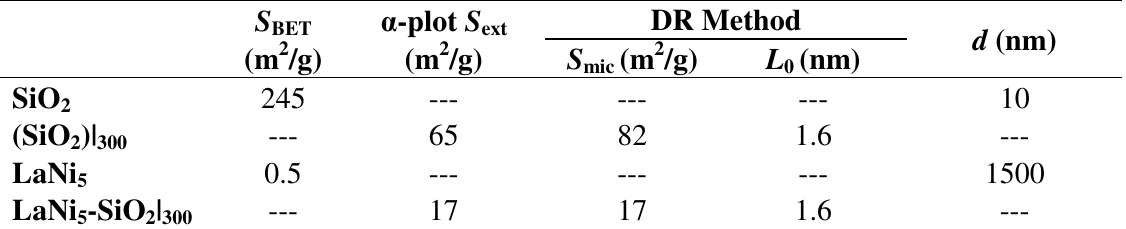
Table 1. Samples surface ( S ) pores dimension ( L resulting from nitrogen adsorption